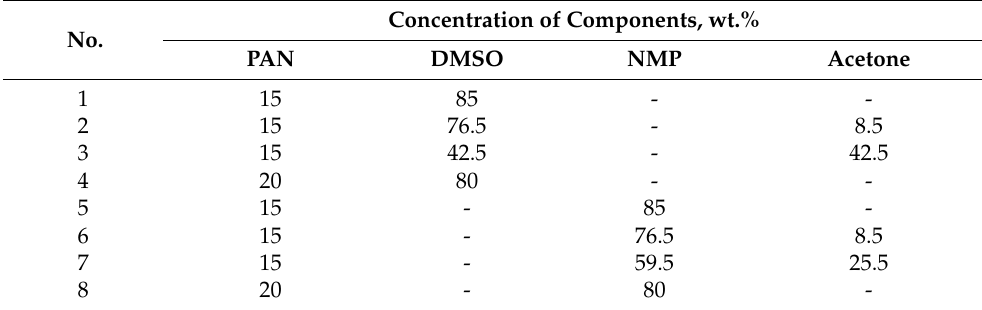
Table 1. The compositions of the mixtures investigated with an optical microscope. Concentration of Components, wt.% No.